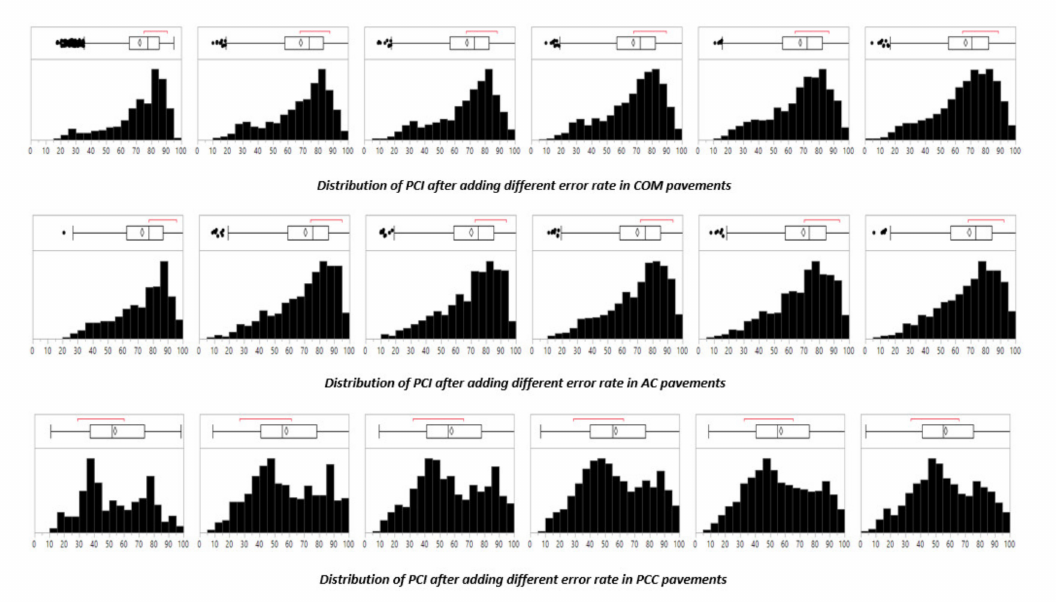
Figure 7. Distribution of PCI in different pavement types after applying the different rate of errors (base scenario, 10%, 30%, 50%, 70%, and 90% rate of error, left to right).